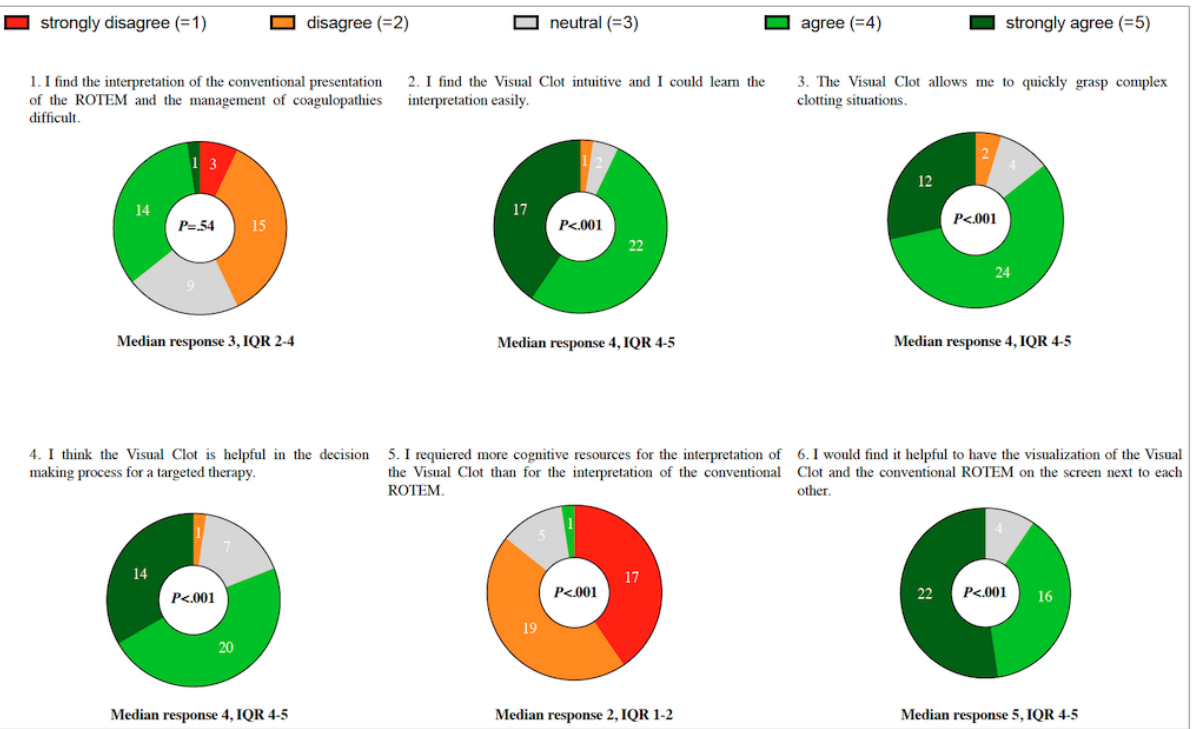
Figure 4. Online survey results presented as donut parts of whole charts with the number of participants who chose a particular category (N=42). We present the results as medians and interquartile ranges and provide P values. ROTEM: rotational